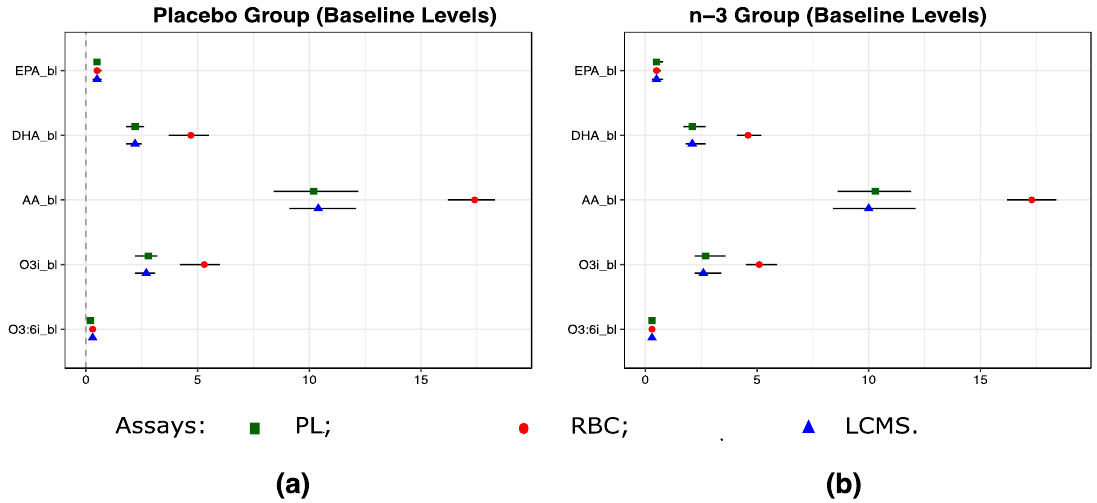
Figure 2. Baseline Levels of EPA, DHA, AA, o3i (EPA + DHA), and o3:6i (o3i:AA) according to the